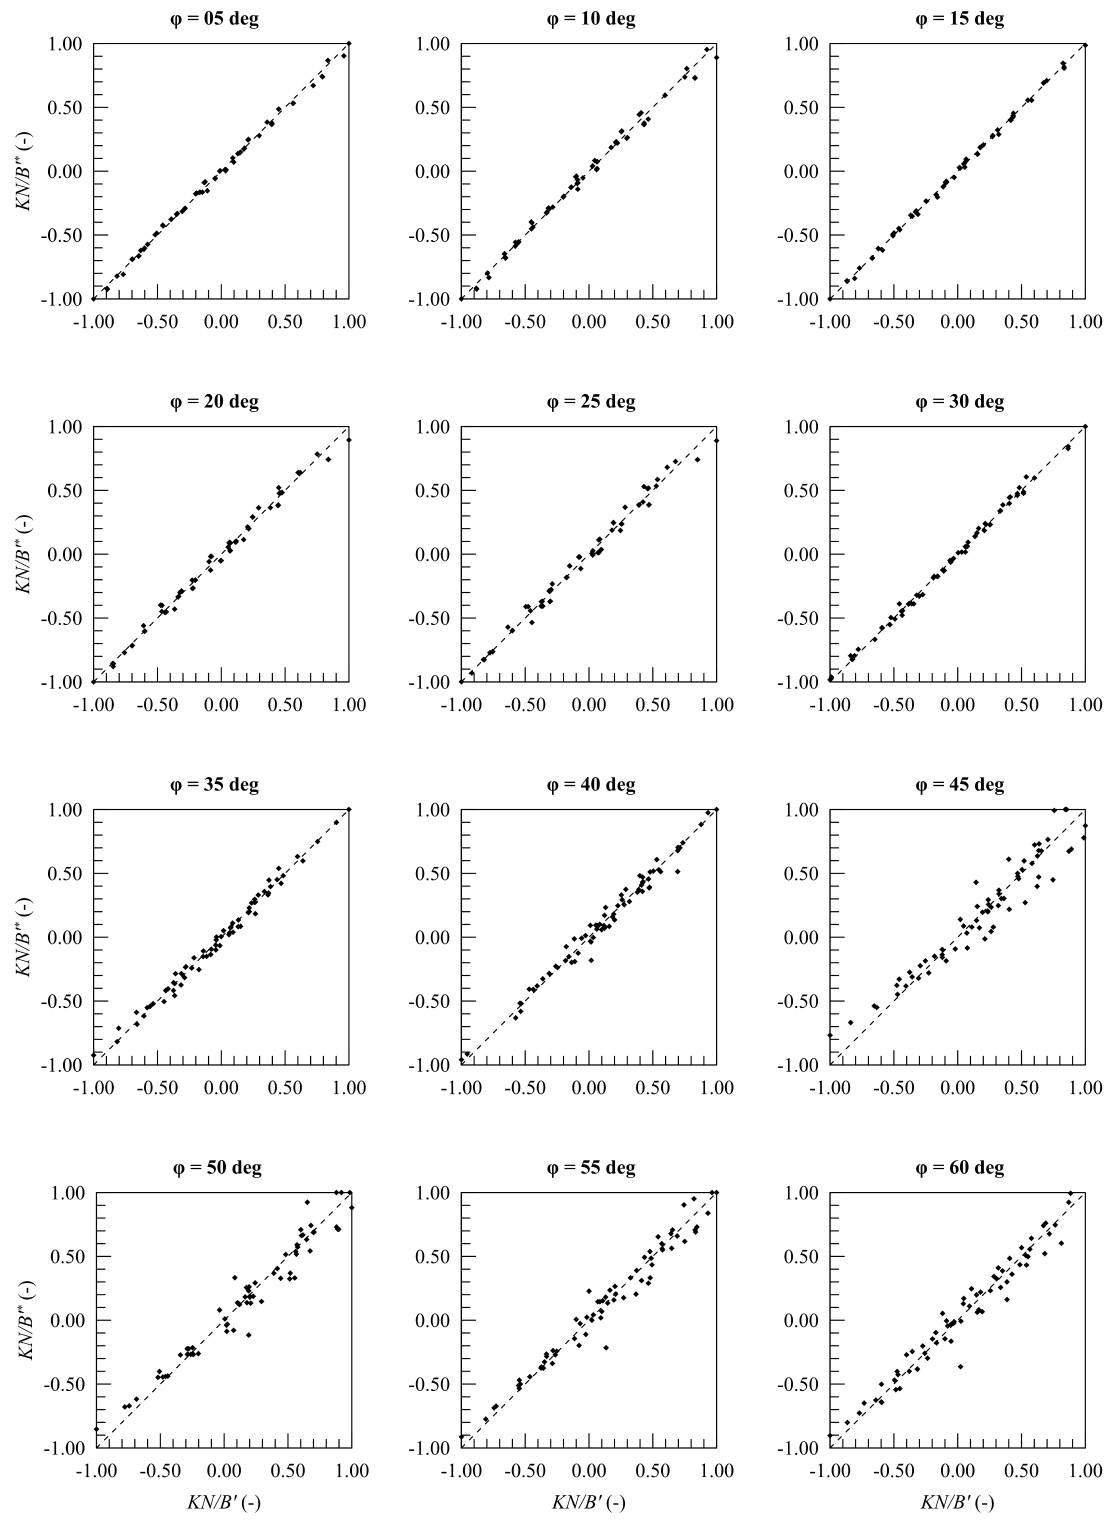
Figure 6. Predicted /observed values for the KN / B